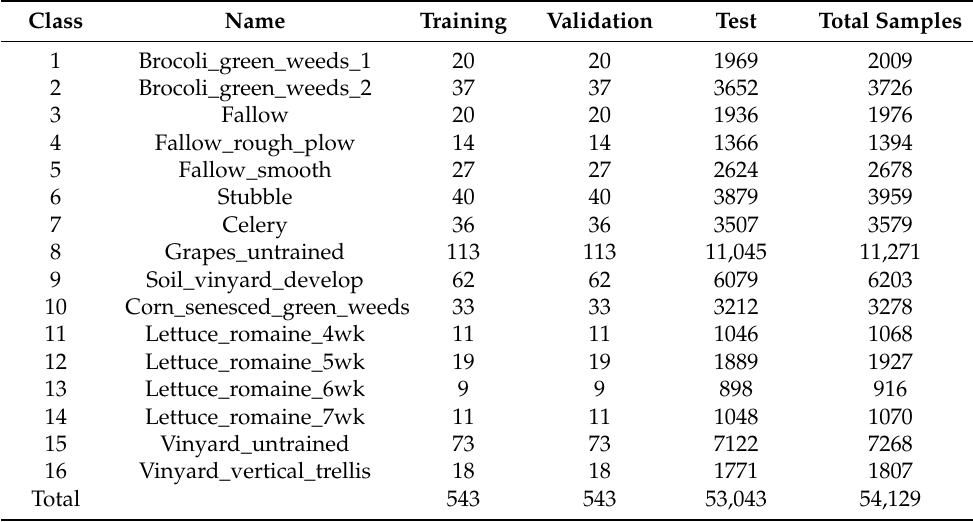
Table 3. Number of training, validation, and testing samples for the SA